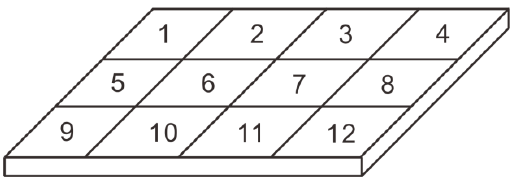
Figure 8. Diagram of PVDF sensor array division.